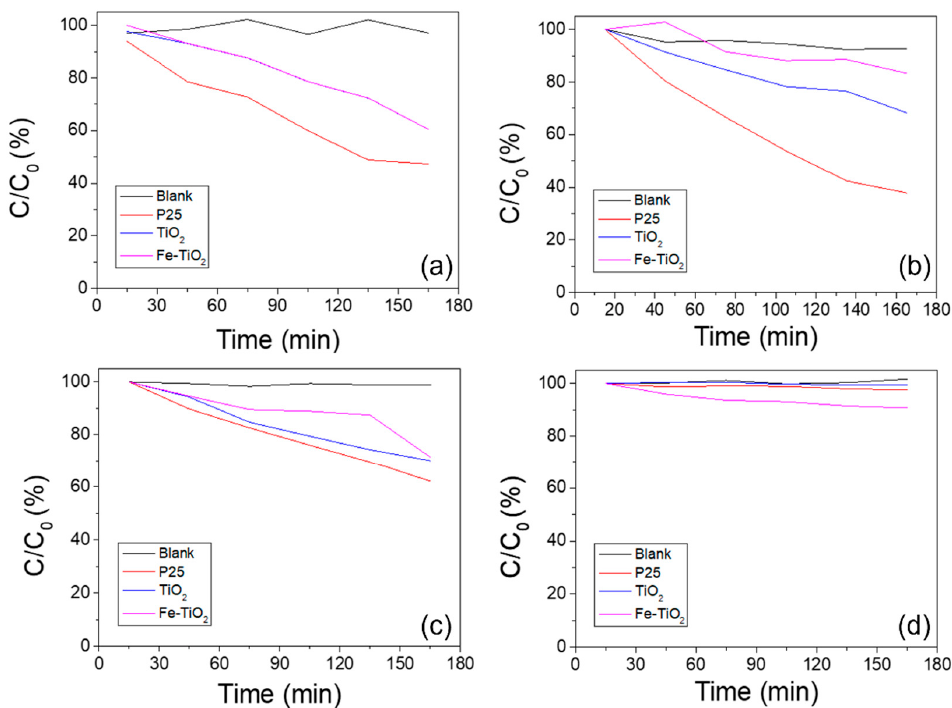
Figure 12. Photodegradation rate of methylene blue and acid orange 7 by various photocatalysts light sources: ( a ) ultraviolet and methylene blue, ( b ) ultraviolet and acid orange 7, ( c ) visible light and methylene blue, ( d ) visible light and acid orange 7.